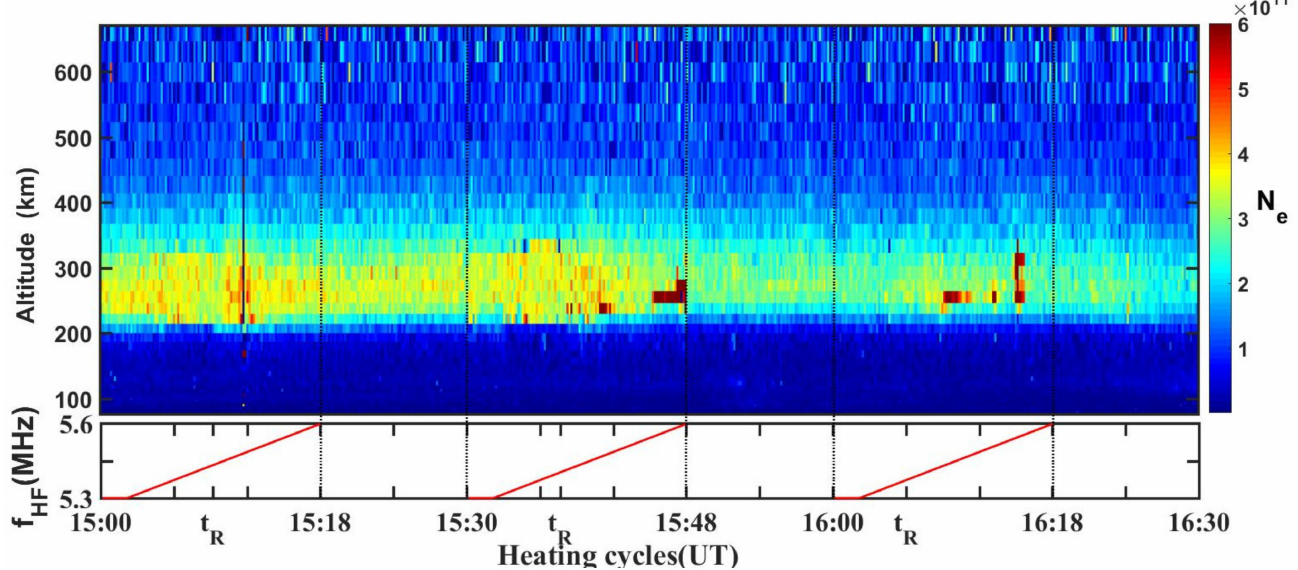
Figure 5. Electron density varies with time (t) and altitude (h) when